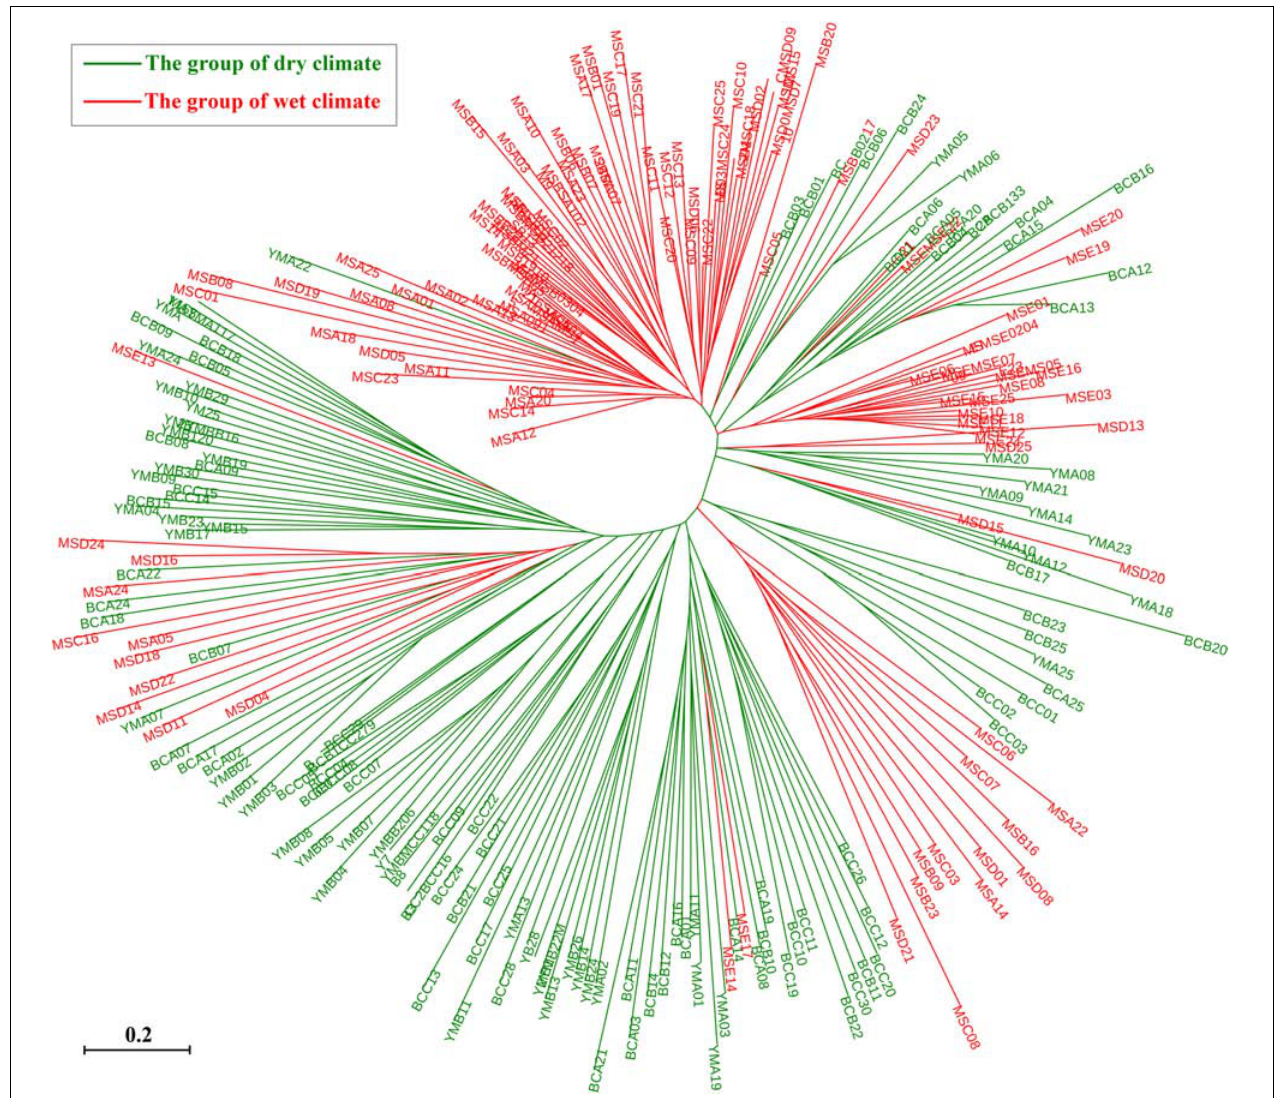
FIGURE 7 | Neighbor-joining tree based on shared allele distance (DAS) between 260 individuals of P. emblica .